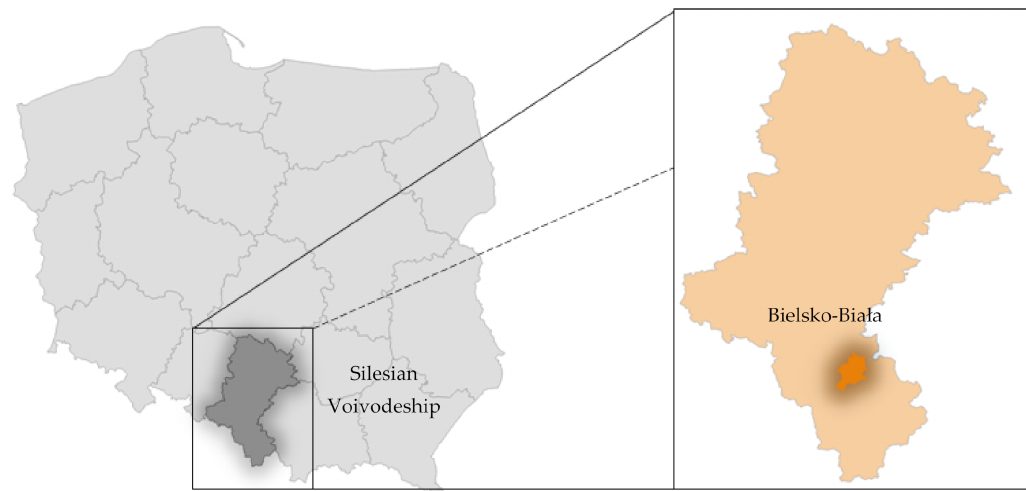
Figure 2. Silesian Voivodeship against the background of Poland, and Bielsko-Biała city against the background of the Silesian